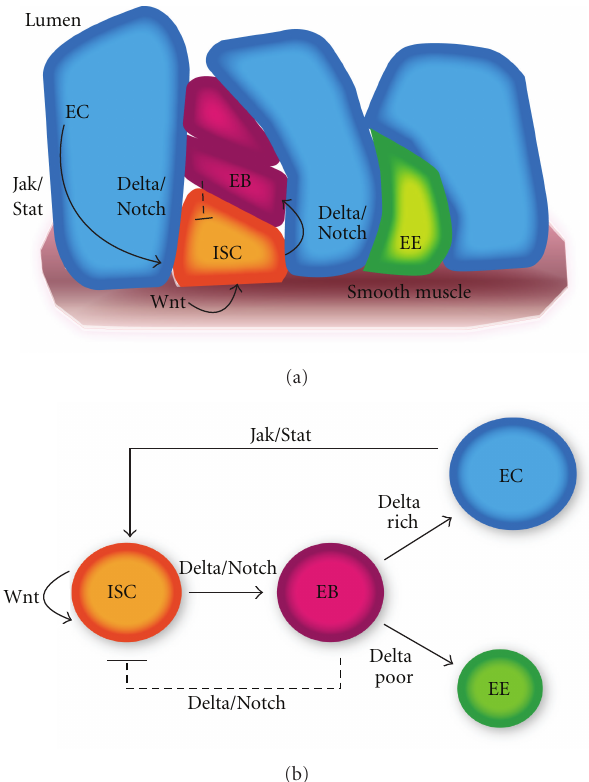
Figure 2: Structural and dynamic aspects of the Drosophila in- testinal stem cell (ISC) niche. The left panel shows a structural picture of the Drosophila intestine, while the right panel reveals population and regulatory elements of a mathematical model for ISC regulation. Populations of the intestinal stem cell niche in the Drosophila include ISCs, enteroblasts (EBs), enteroendocrine cells (EE), and enterocytes (ECs). Wnt signaling from underlying smooth muscle and Notch feedback from EB regulate ISC self- renewal, while Jak/Stat feedback from damaged ECs increases ISC